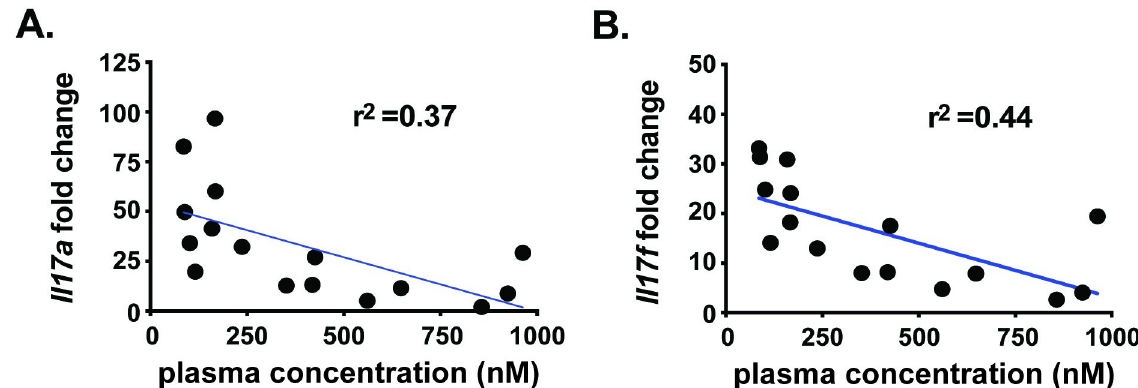
Fig 6. Compound 3 plasma concentration inversely correlates with Th17 cytokine gene expression. Th17 cytokine gene expression analysis was performed for Il17a (A) and Il17f (B) from IMQ-treated animals dosed with 6 or 60 mg/kg Compound 3 . Gene expression is normalized to Gapdh and presented as fold change over na ï ve and plotted relative to plasma concentrations for Compound 3 . Each symbol represents an individual animal and a linear regression (blue line) coefficient was calculated. Statistical significance ( � p � 0.05) was determined using linear regression analysis. Data are from a single experiment with n = 8/group.